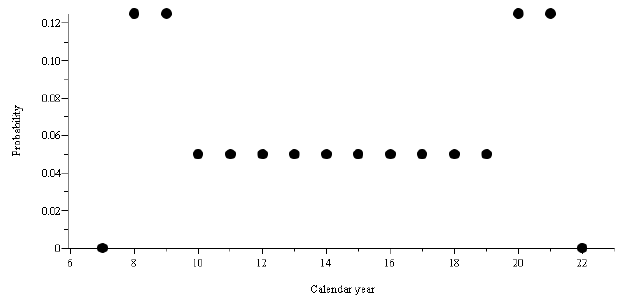
Fig. 7. Calibration graph of the sample whose age distribution is given by Table 1 (via the calibration curve in Fig. 5).